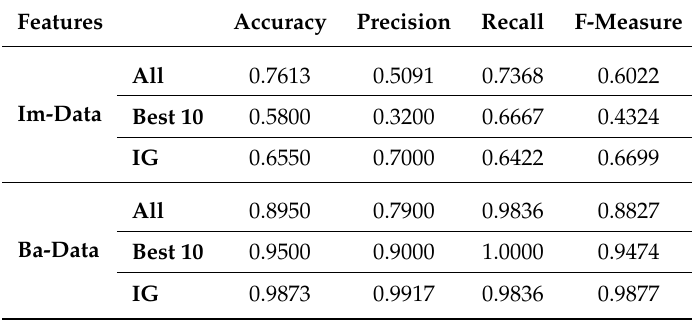
Table 7. DeepDCA performance based on Features Impact among Imbalanced and Balanced